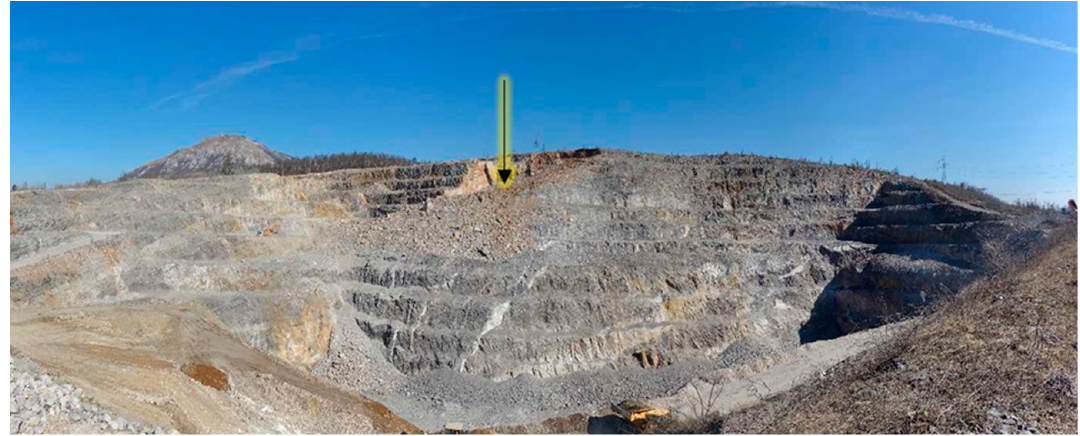
Figure 1. View toward the north. The collapsed area is marked with an arrow.